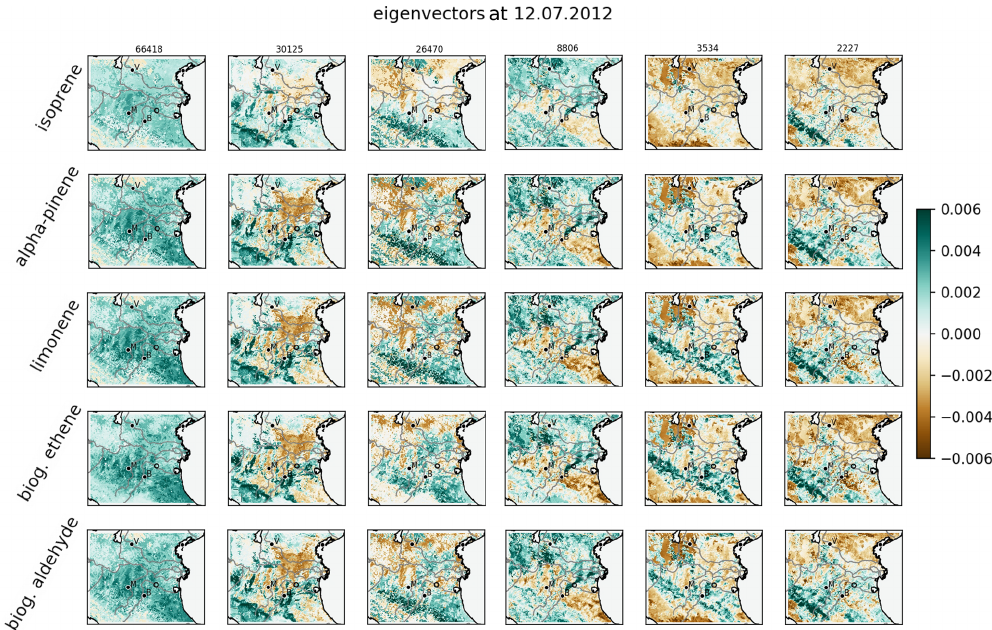
Figure 8. Leading eigenvectors for independent sensitivities including additional uncertainties. Plotting conventions are the same as in as in Fig. 6.